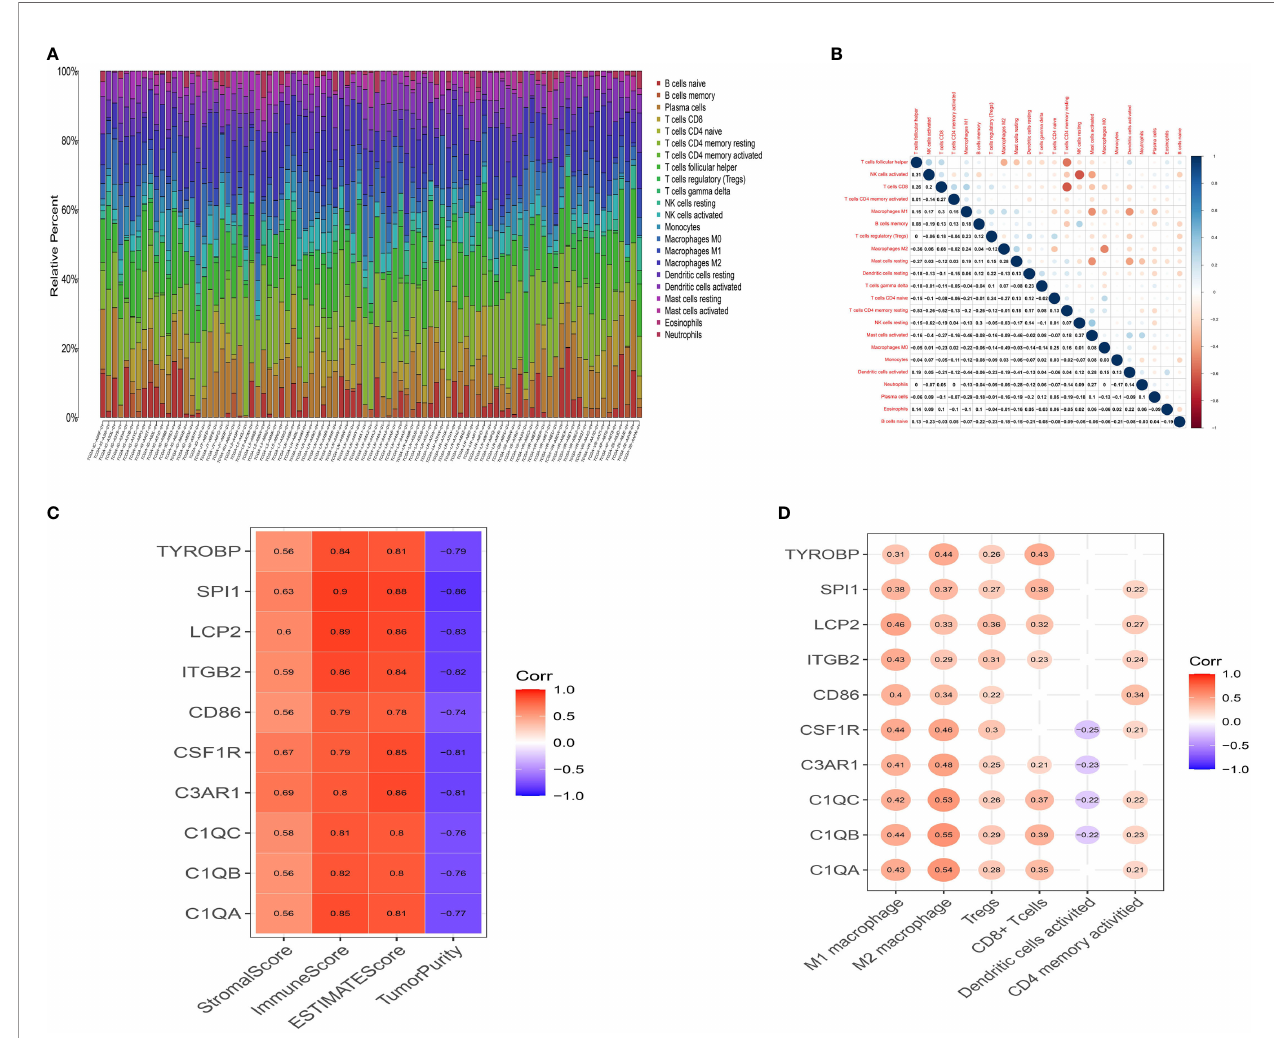
FIGURE 5 | Landscape of tumor in fi ltration cells in ESCC. (A) Barplot for the proportion of 22 types of immune cells in ESCC tissues. Column names are sample ID. (B) Heatmap for the correlations between the levels of immune cells among ESCC samples. (C) Heatmap for correlation between 10 genes and StromalScore, ImmuneScore, ESTIMATEScore and TumorPurity (p<0.05). (D) Heatmap for correlation between 10 genes and six immune cells. The blank means that the p-value is nonsigni fi